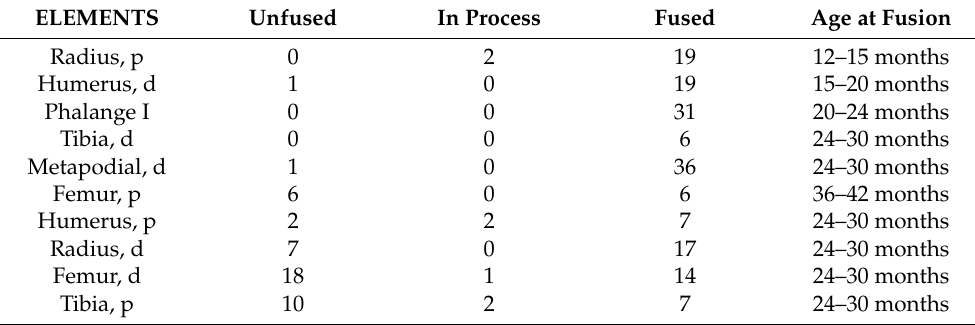
Table 5. Number of cattle with unfused, in the process of fusion, and fused remains recovered from the Vilauba pit (p = proximal; d =